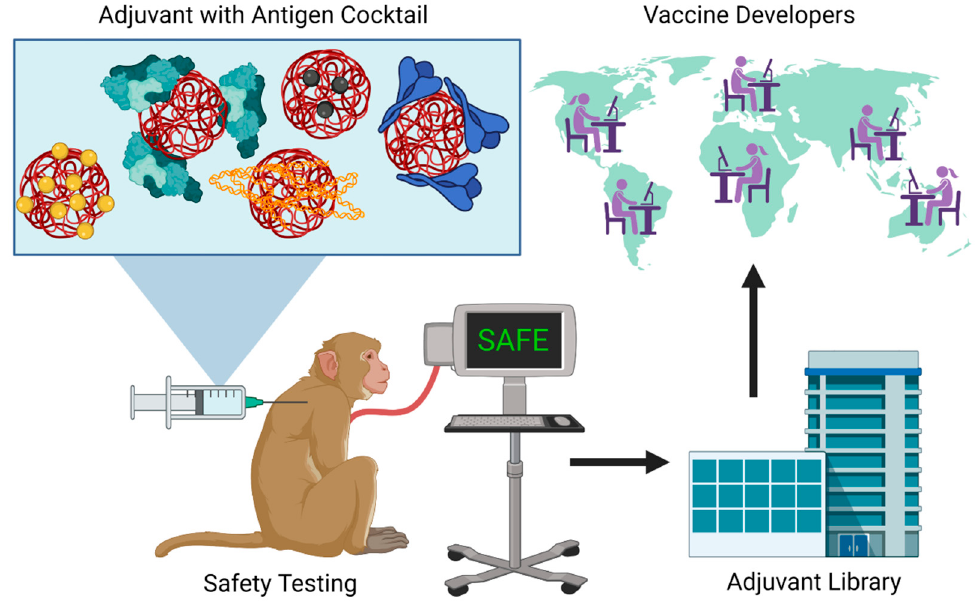
Figure 2. A single adjuvant can be mixed with multiple antigens for safety testing in NHP. Standardized adjuvant formulations and protocols can then be shared with the adjuvant library for global distribution to vaccine developers for rapid vaccine development to pandemic antigens.